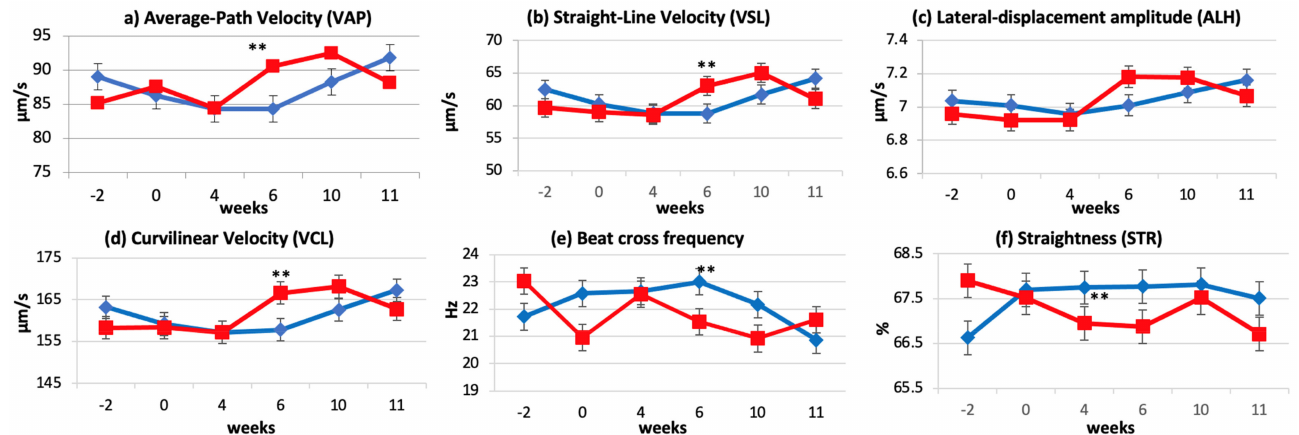
Figure 3. Effect of CLA dietary supplementation on post-thaw bovine semen CASA-derived kinematic parameters of: VAP ( a ); VSL ( b ); ALH ( c ); VCL ( d ); BCF ( e ); and STR ( f ). (LSM ± SE) for the control (CTL (cid:7) ), and CLA ( (cid:4) ) group; ** significant levels trt × week as p ≤ 0.05; * trend trt × week at p ≤